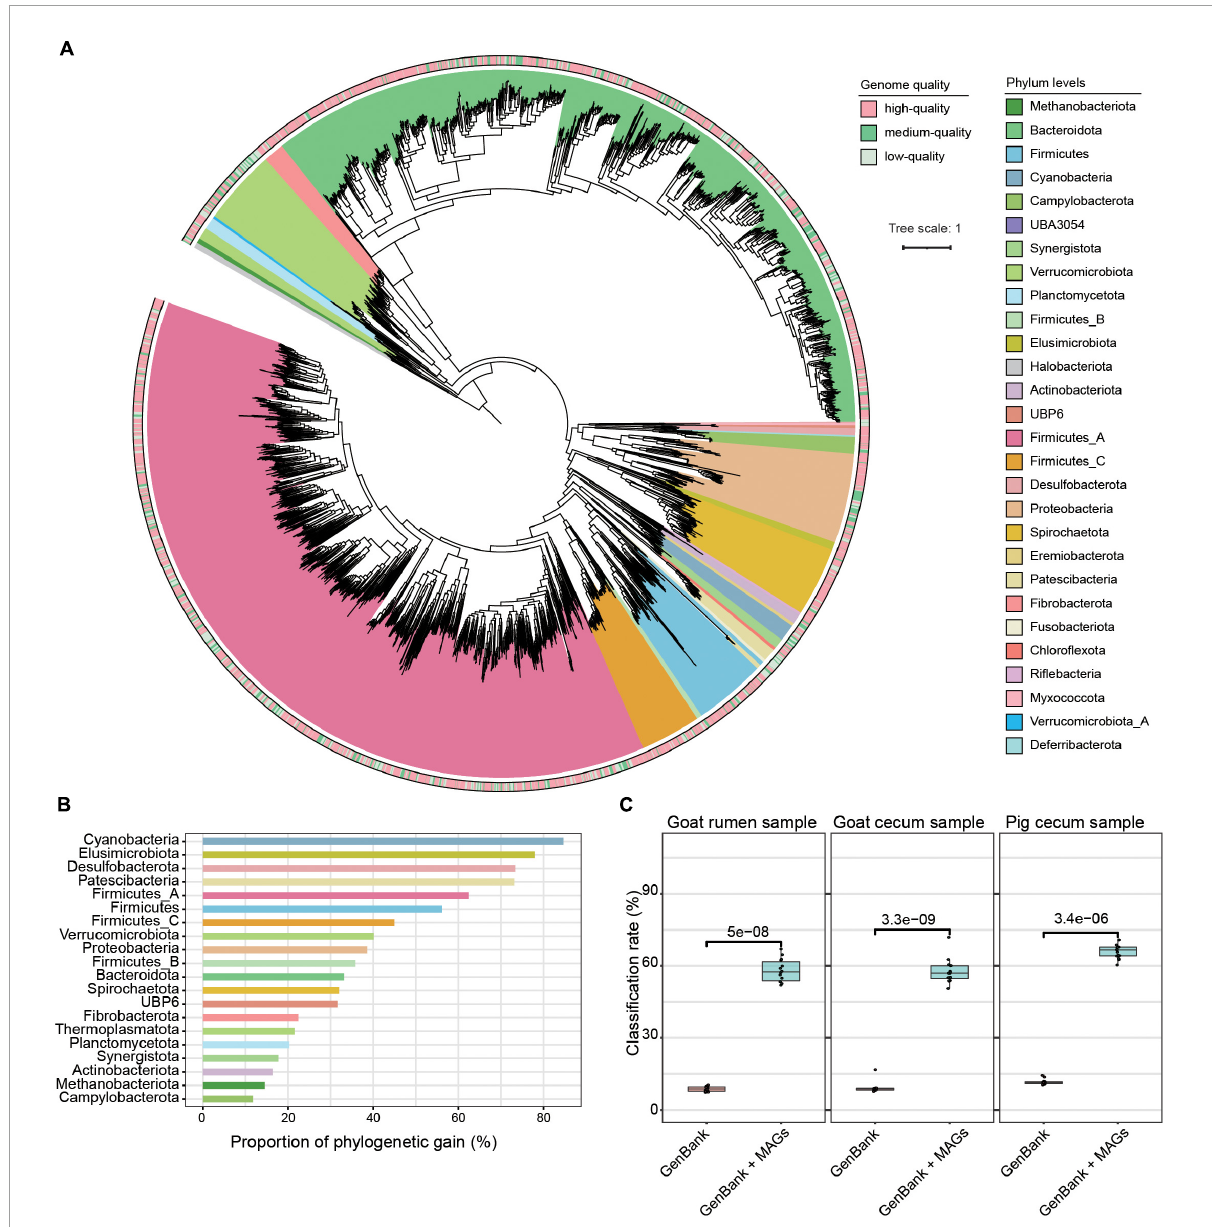
FIGURE1 Taxonomic annotation and phylogenetic tree of 3,262 metagenome-assembled genomes (MAGs). (A) The maximum-likelihood tree of the 3,262 MAGs identified in this study was produced from concatenated protein sequences using PhyloPhlAn. (B) The phylogenetic gain contributed by the microbial tree of the gut provided by the unknown species-level genome bins is shown as proportional increases in branch length per phylum (left) and absolute branch lengths (right). (C) Comparison of the read classification rates of all the digesta samples using the following datasets: a common database consisting of all complete microbial genomes in RefSeq and the GenBank database plus MAGs. The Wilcoxon rank-sum test was used to assess the